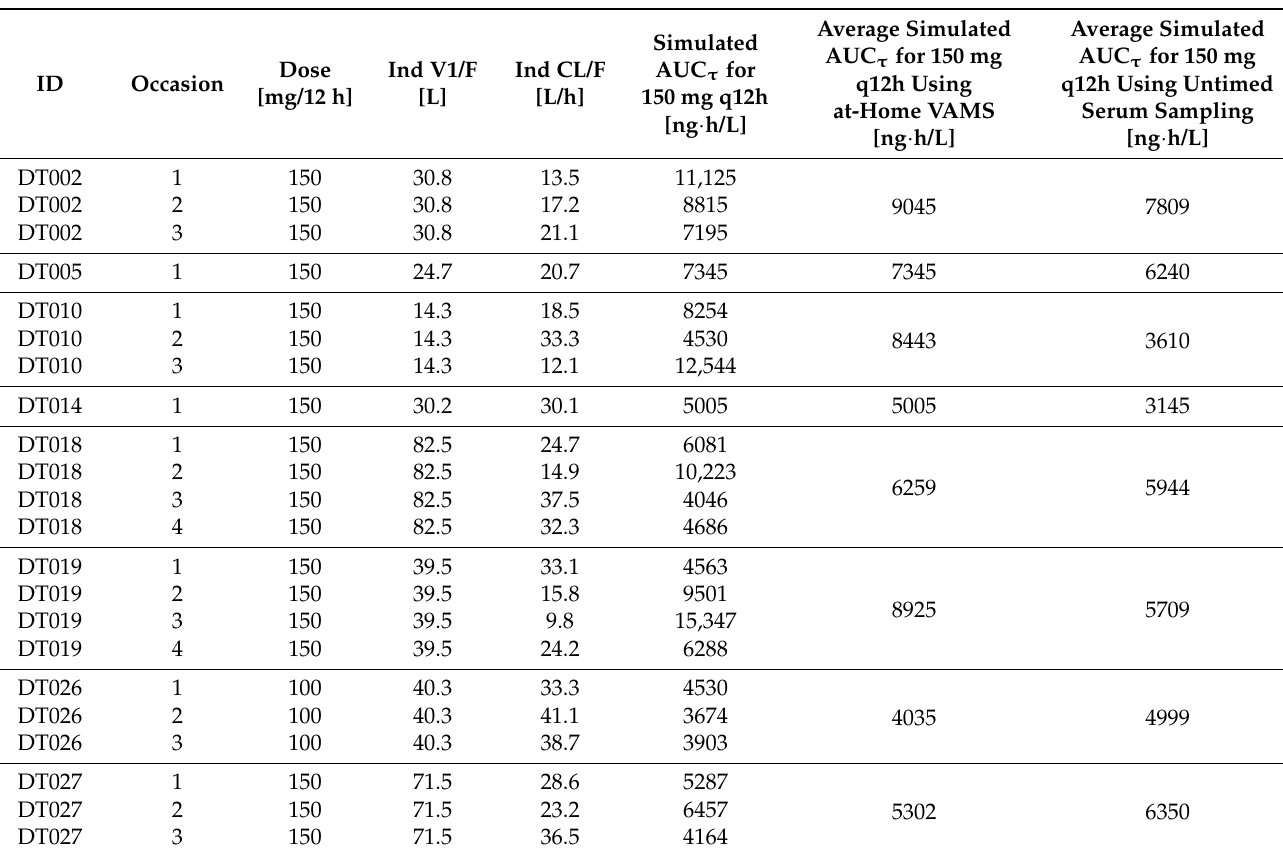
MAP estimates for dabrafenib serum pharmacokinetic parameters using at-home sampled VAMS.